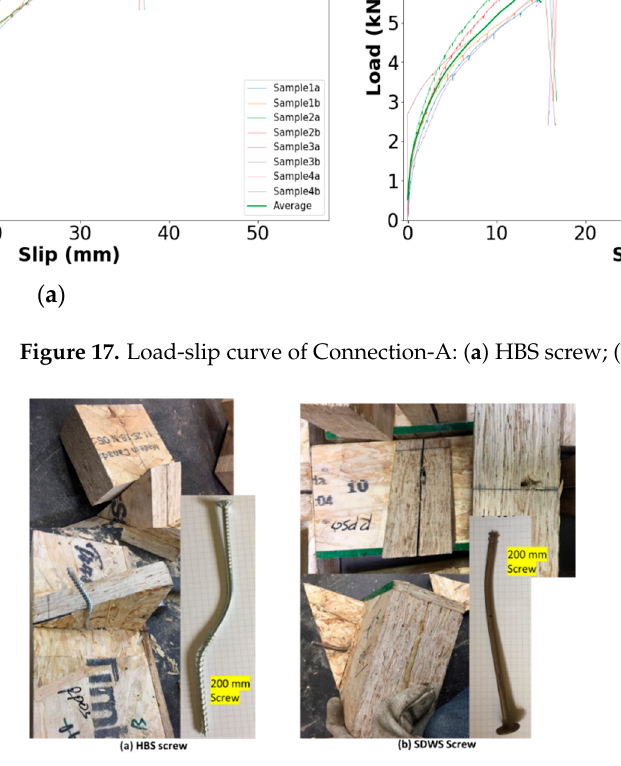
Figure 18. Failure of mode of Connection-A in shear loading: ( a ) HBS screw; ( b ) SDWS screw.